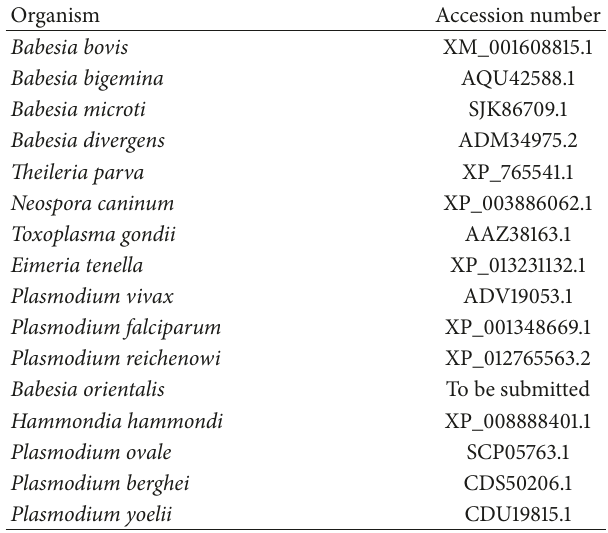
Table 1: Apicomplexan species used for alignment and phylogenetic